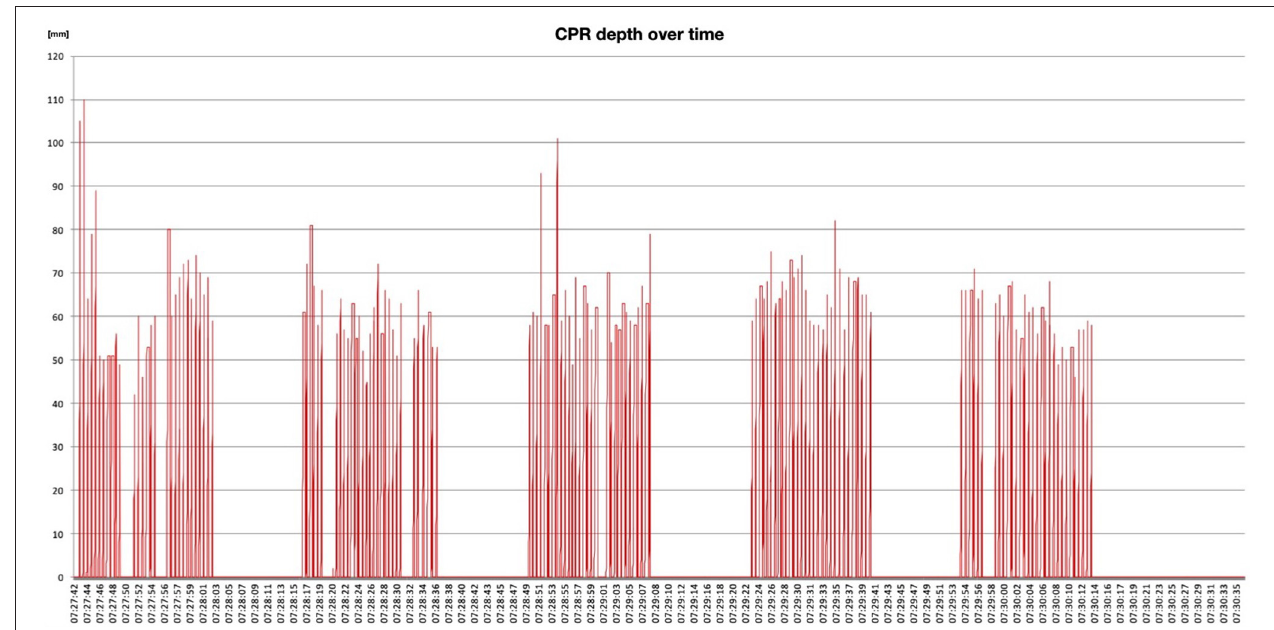
FIGURE 2 | CPR plan: example of one registration during CPR simulation, reporting chest compression frequency and depth over time.